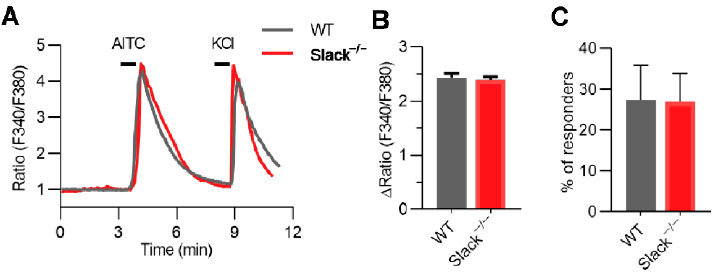
Figure 4. AITC-mediated calcium influx is normal in sensory neurons of Slack − / − mice. ( A ) Repre- sentative examples of Fura-2-ratiometric calcium traces evoked by AITC and KCl in cultured lumbar DRG neurons of WT and Slack − / − mice. ( B ) Magnitude of the calcium response to AITC stimulation (WT, n = 452 neurons in 3 mice; Slack − / − , n = 476 neurons in 3 mice; p = 0.7000). ( C ) Percentage of responsive neurons to AITC stimulation ( p = 0.9739). These data show that AITC-evoked calcium responses are normal in DRG neurons from Slack − / − mice. Data in B and C are presented as mean ± SEM.